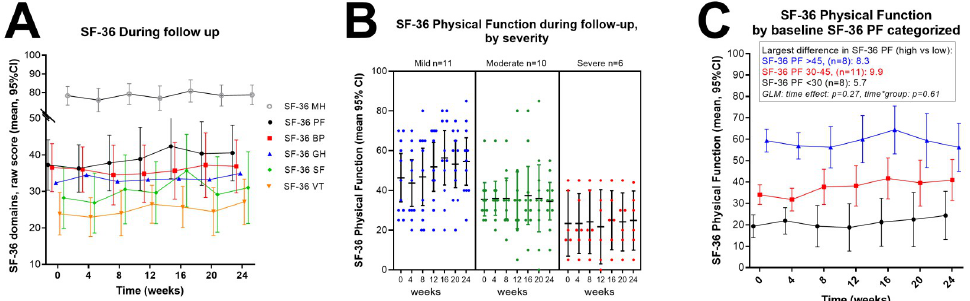
Fig 6. SF-36 subdomains (mean, 95% CI) during follow up; SF36 Physical Function (SF-36 PF) by severity categories, and by categories of baseline SF-36 PF. (A) SF-36 domains during follow-up; MH: Mental Health, PF: Physical Function, BP: Bodily pain, GH: General health, SF: Social function and VT: Vitality. Raw scores, scale 0–100, lower scores denote lower function. (B) SF-36 Physical Function (mean, 95% CI) during follow up shown in separate panels, for the severity categories. (C) SF-36 Physical Function (mean, 95% CI) during follow-up by three categories based on the baseline level of SF-36 PF; < 30, 30–45, and > 45. General Linear Model (GLM) for repeated measures with p values for time effect and for interaction time-by-group are